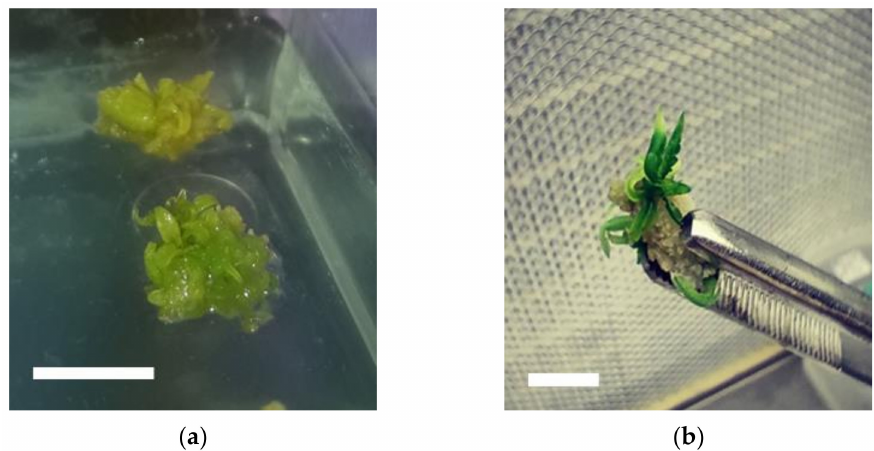
Figure 2. Shoot formation and plant regeneration from callus: ( a ) organogenesis in nodal segment explants of Cannabis sativa L. on MS medium containing 4.44 µ M BA after 2 weeks of culture; ( b ) plant regeneration from callus formed in nodal segment explants on MS medium containing 4.44 µ M BA after 3 weeks of culture. Bars = 1 cm.